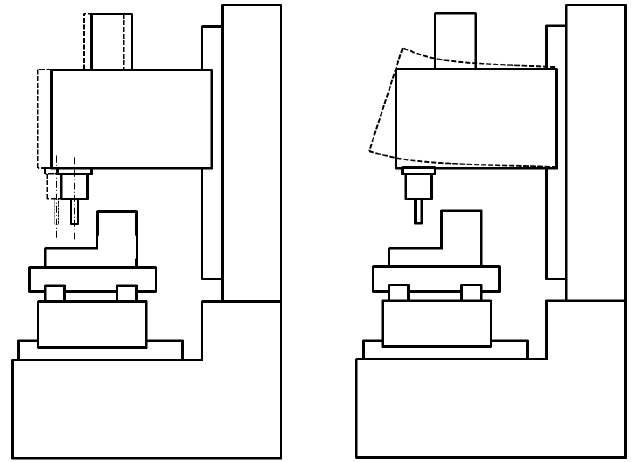
Figure 1. Thermal deformation of machine tools.